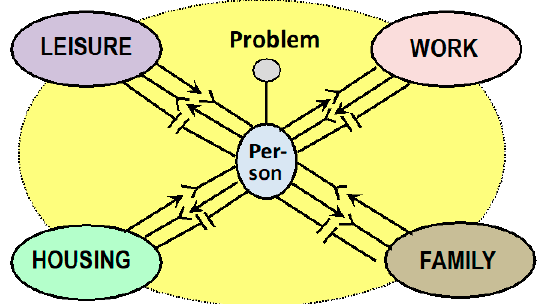
Figure 3. Conceptual framework for a systemic understanding of the reciprocal relationship of the person to their environment with areas of life as the life world . For every micro-area—housing, family, work, leisure—there are give–take relationships, which in their totality can co-determine the psychophysical state of health and thus the health of the person or causes of illness. Health is therefore finally the product of comprehensively successful person–environment fits.